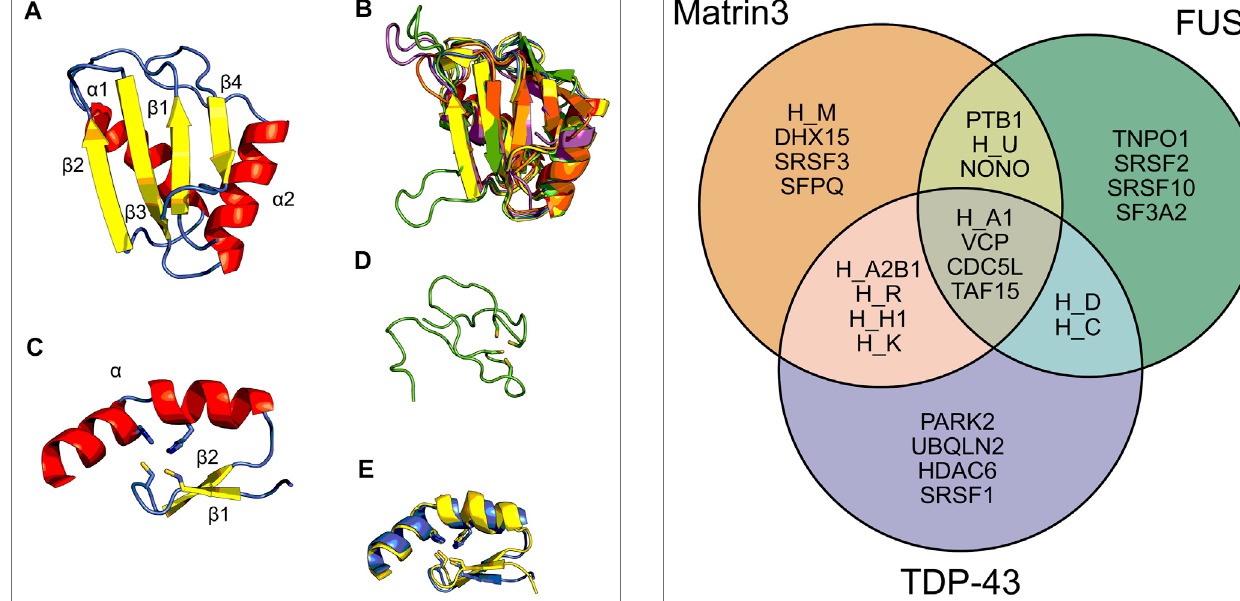
FIGURE 3 | Shared interaction partners between Matrin3, FUS and TDP-43. Venn diagram showing the overlapping protein interaction partners shared between three primary ALS proteins. The appreviation ‘ H ’ is used for “ HNRNP ” (i.e., HNRNPA1 (cid:1) H_A1). Interaction assignment is based on the STRING protein-protein interaction network (Szklarczyk et al.,